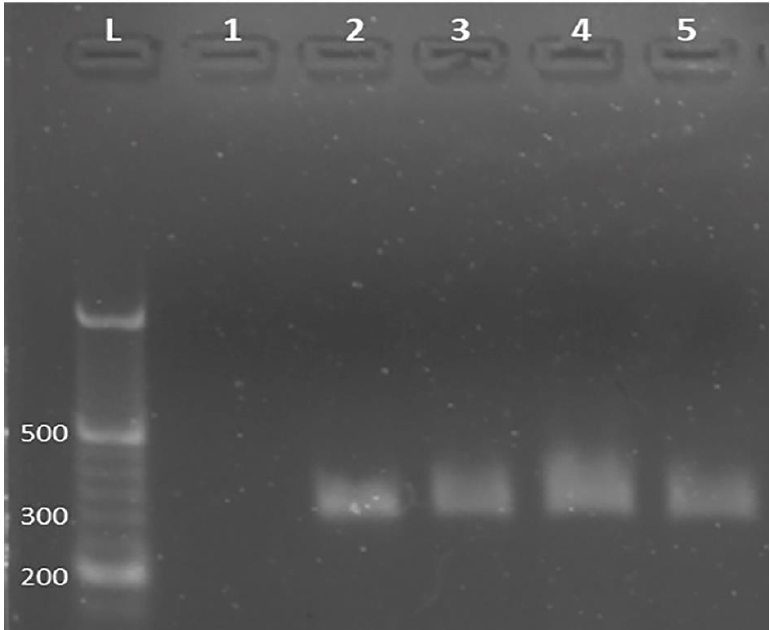
Figure 7 Figure 7. Non-denaturing agarose (2%) gel electrophoresis of 10 µ g/mL curcumin (lane 1), 25 µ g/mL PCR sample in the absence of curcumin (312 bp, lane 2), and 10 µ g/mL curcumin-incubated PCR samples (25 µ g/mL) during 1, 3, and 5 min (lane 3, 4, and 5, respectively). In all incubated PCR samples with curcumin, the ethidium bromide intensity decreased, compared to control PCR sample (lane 2). L: 50 bp DNA